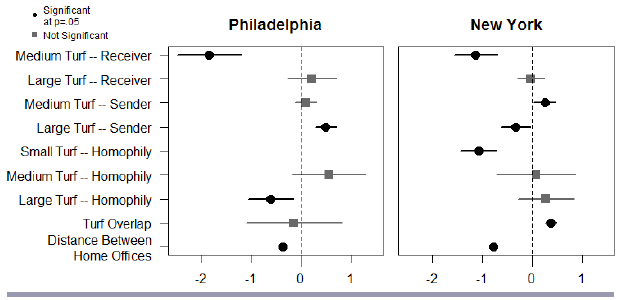
Fig. 4 . Odds ratios for Spatial exponential random graph (ERG) terms for Philadelphia and New York City ERG